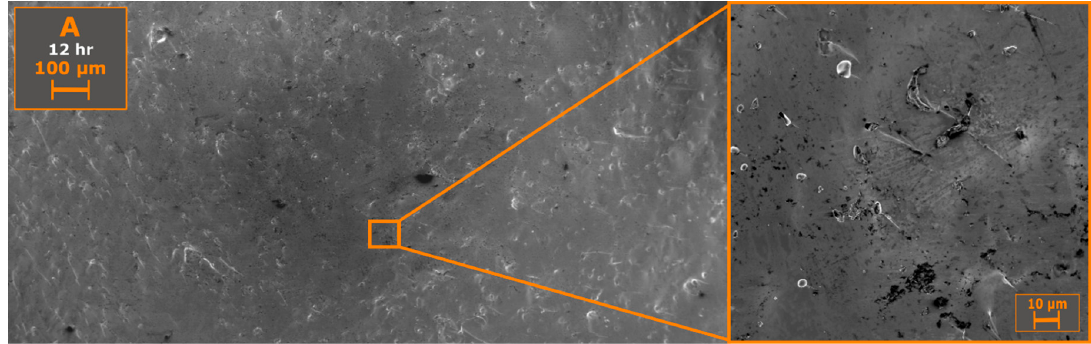
Figure 6 . SEM backscattered micrograph on a fractured surface showing low porosity, as well as the presence of carbon nodule impurities.